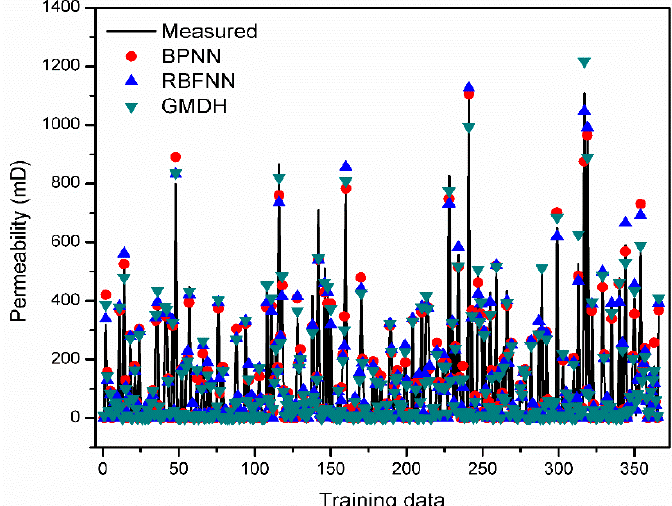
Figure 7. GMDH and artificial neural network (ANN) prediction in comparison with measured permeability data during training.